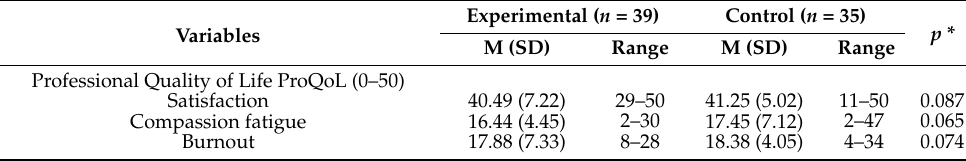
Table 1. Subscales of the ProQoL questionnaire at baseline for the control and intervention groups.